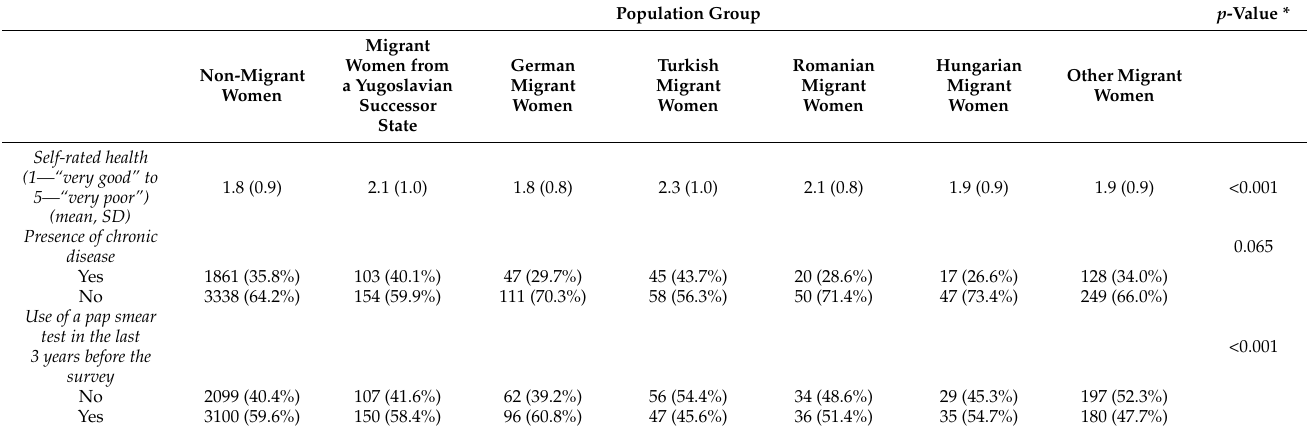
Table 1. Cont. Population Group p -Value *